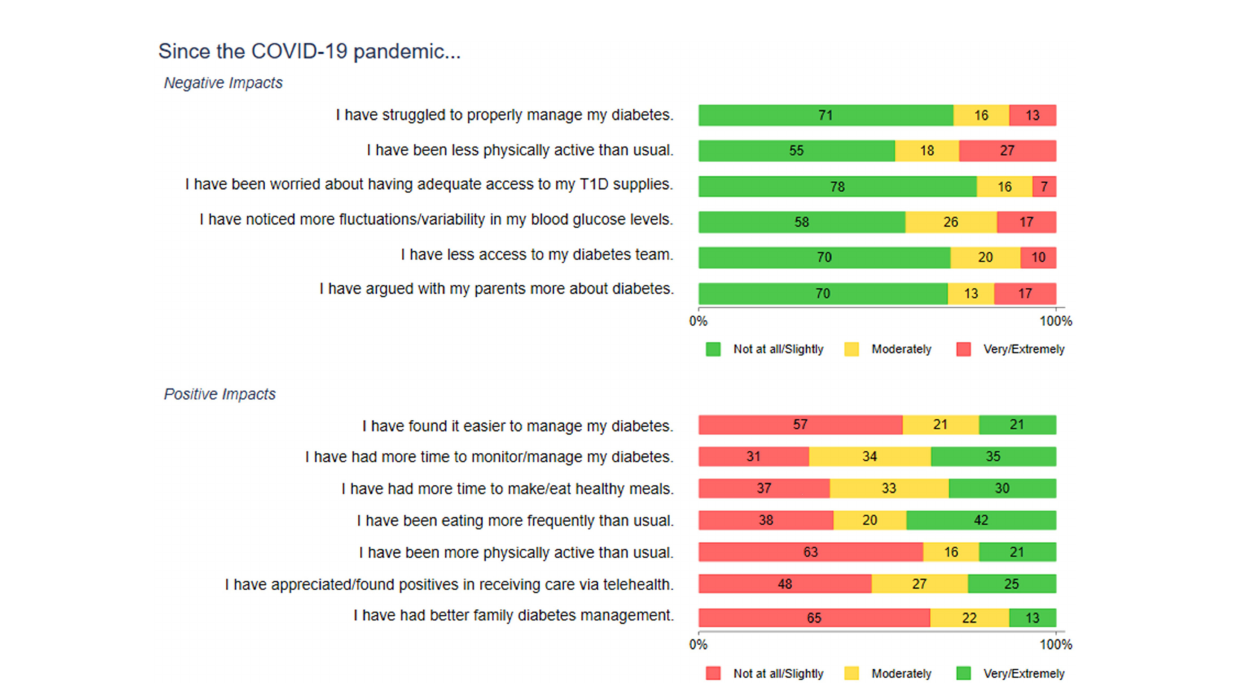
FIGURE 3 | Negative and positive impacts of COVID-19 on diabetes management. Numbers shown are percentages.